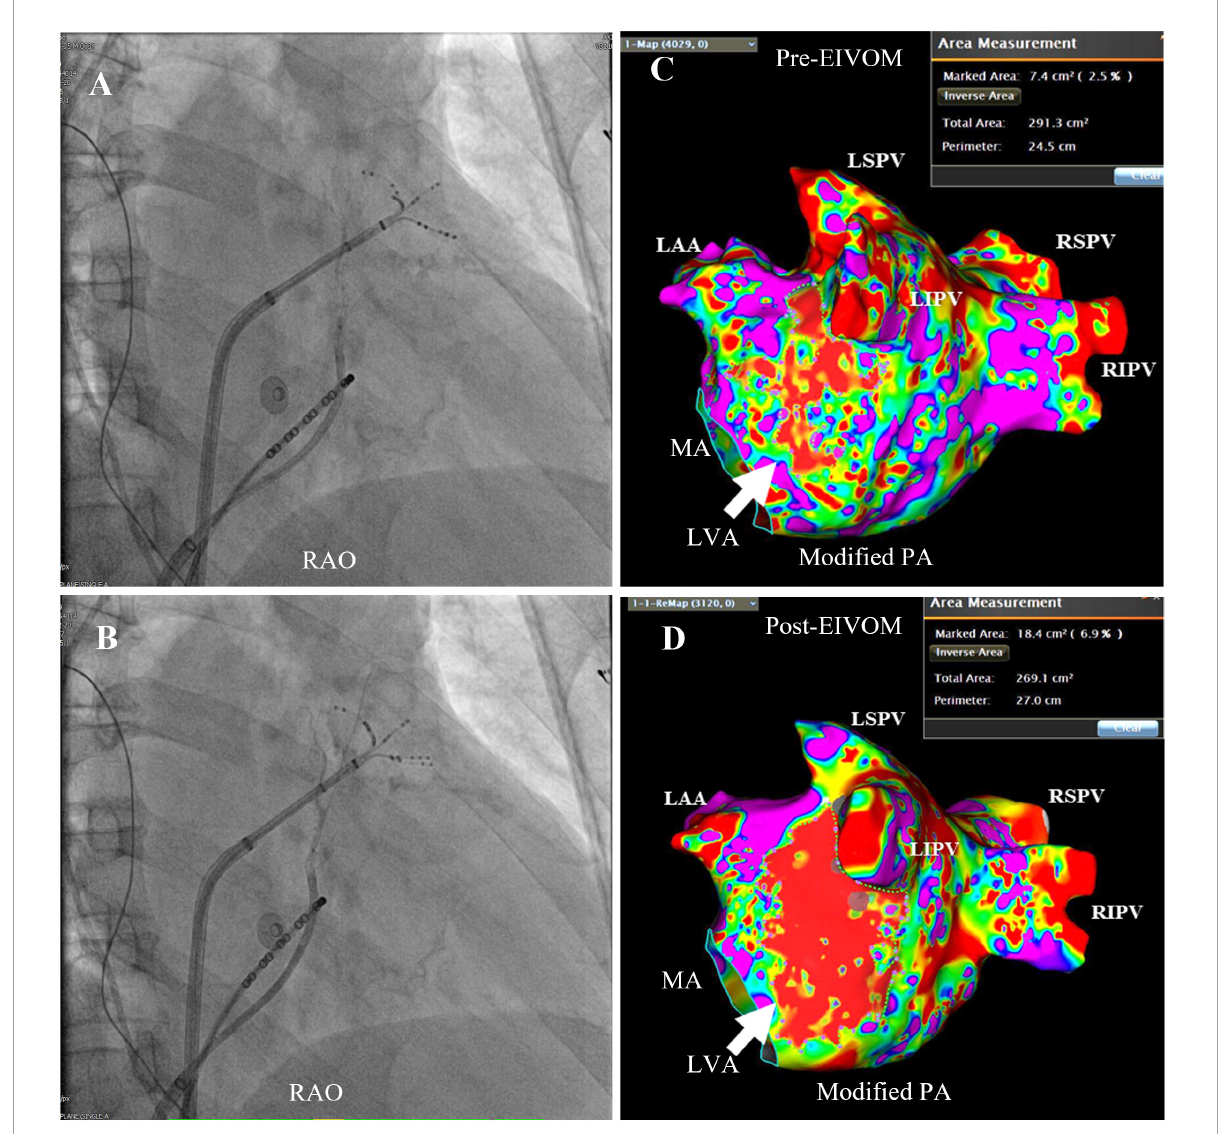
FIGURE1 Selective venography of the EIVOM and LVA measurement. (A) The balloon at the proximal VOM was inflated at 7 atm, and selective venography displayed one small tortuous VOM with two distal branches, coursing upward behind the ostium of the LAA (the PentaRay catheter at the LAA). While in panel (B) , after balloon inflation at 8 atm, repeated venography showed another long and straight proximal branch of VOM [invisible in panel (A) ], indicating the balloon was completely occluded in panels (B) and not in panel (A) . This example highlighted the importance total occlusion of the OTW before ethanol infusion. (C,D) LA substrate mapping pre- and post- EIVOM. Note the size of LVA (white arrow) markedly increased from 7.4 cm 2 pre-EIVOM to 18.4 cm 2 post-EIVOM. RAO, right anterior oblique; PA, postero-anterior; LSPV, left superior pulmonary vein; RSPV, right superior pulmonary vein; LIPV, left inferior pulmonary vein; RIPV, right inferior pulmonary vein; LAA, left atrial appendage; MA, mitral annulus; LVA, low voltage